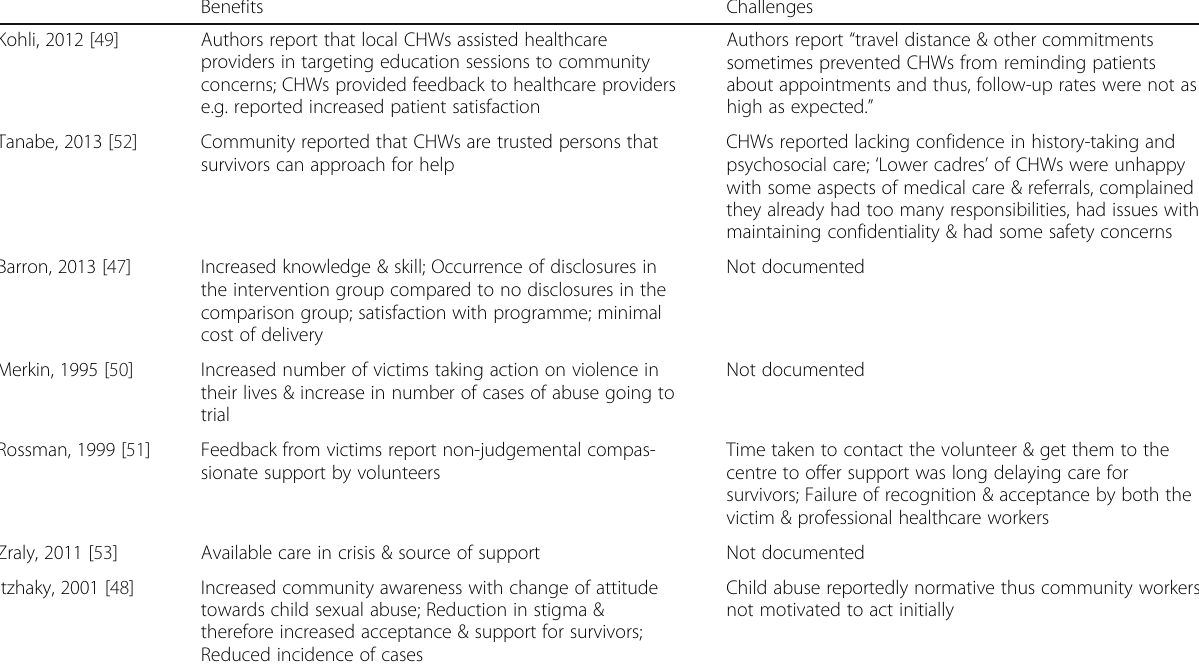
Table 7 Reported benefits and challenges of CHWs in sexual violence services Benefits